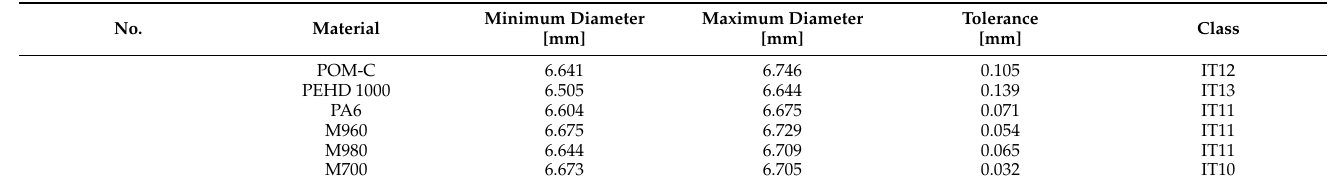
Table 9. Accuracy classes according to the minimum and maximum values of the hole regardless of the cutting regime.